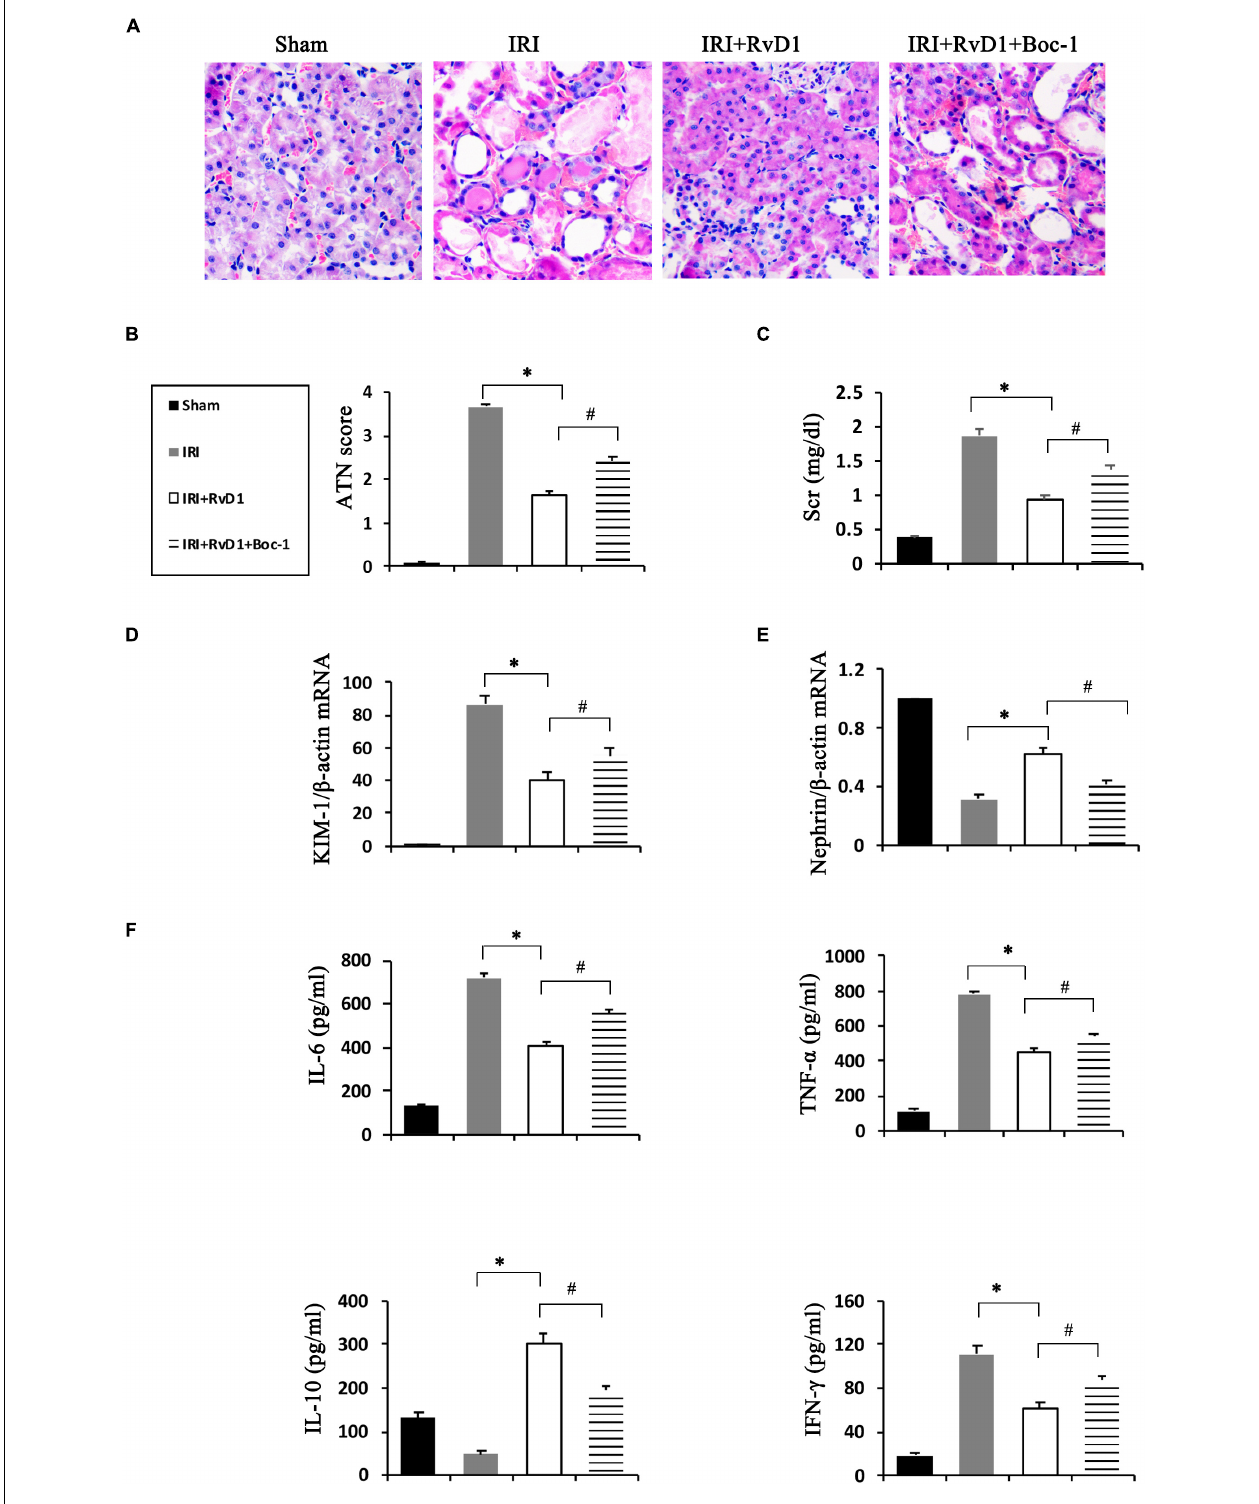
FIGURE 7 | Boc-1 reversed the improved therapeutic efficacy of RvD1 in IRI-AKI. (A) Kidneys were stained by PAS (original magnification, 400 × ). (B) ATN scores at 72 h after reperfusion. (C) Serum creatinine levels at 72 h after reperfusion. The relative mRNA expression of KIM-1 (D) and Nephrin (E) at 72 h after reperfusion. (F) Serum IL-6, TNF- α , IL-10 and IFN- γ levels at 72 h after reperfusion as determined by ELISA. Values are expressed as the means ± SDs, n = 6–8 per group. ∗ P < 0.05, IRI versus IRI + RvD1; # P < 0.05, IRI + RvD1 versus IRI + RvD1 + Boc-1.